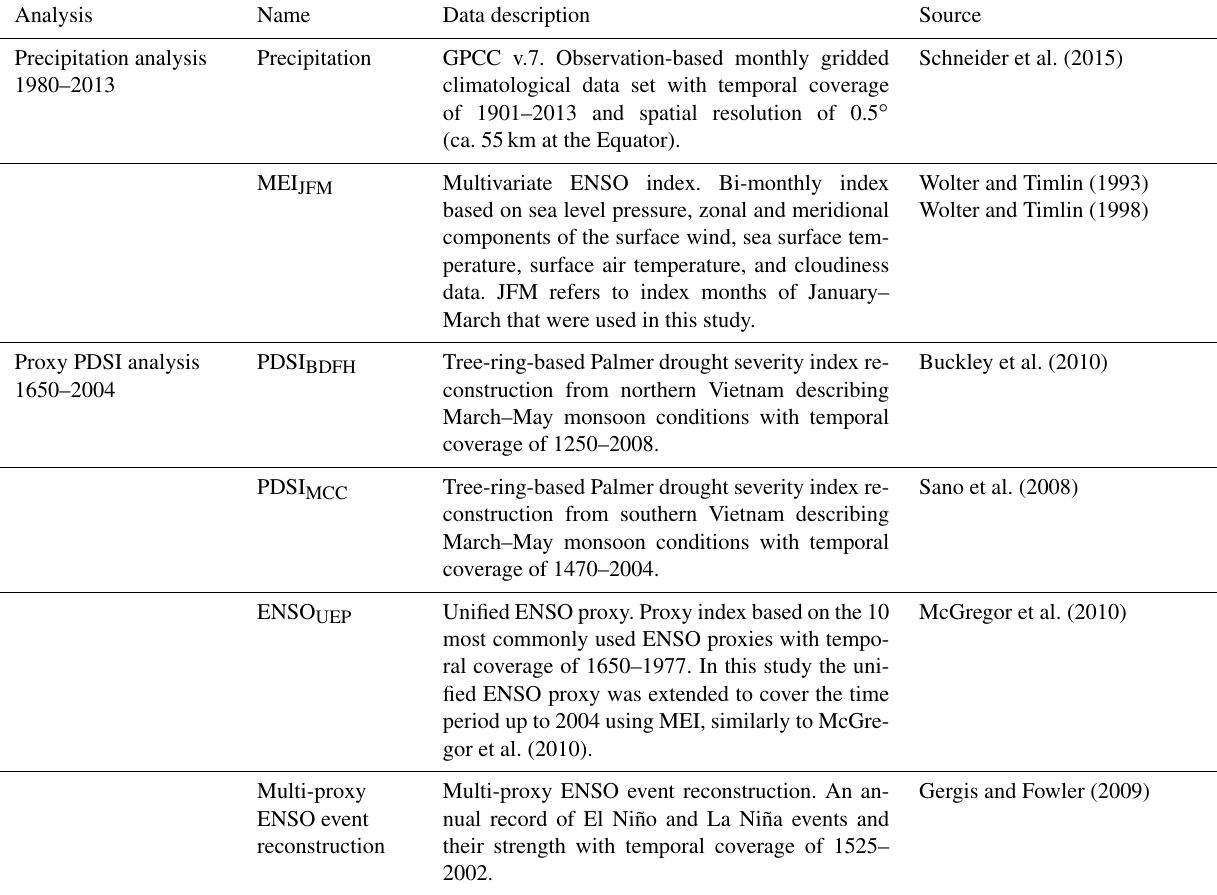
Table 1. Description of the data sets used in the analyses of this